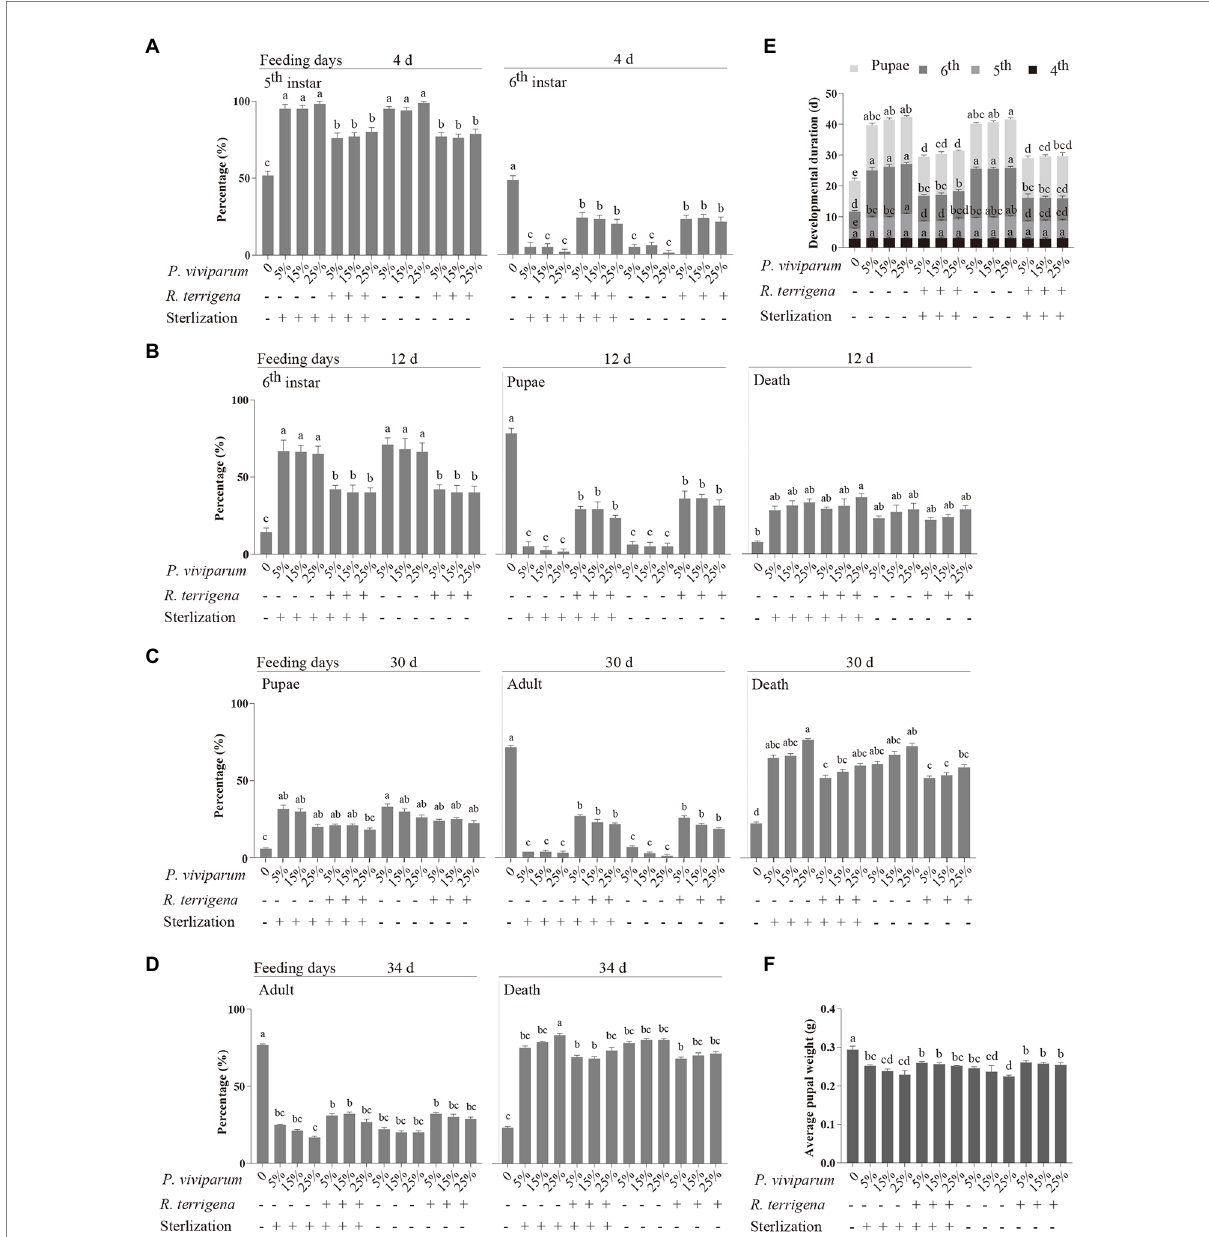
FIGURE 2 Development of the fourth instar larvae of Spodoptera litura reared on the artificial diets supplemented with 5, 15 or 25% P. viviparum root powder which was cocultured with or without R. terrigena for 7 days. Percentages of different developmental stages of S. litura for 4 day (A), 12 day (B) , 30 day (C) and 34 day (D) , developmental durations of the different developmental stages of S. litura (E) and average pupal weight of S. litura on the first day post pupation (F)